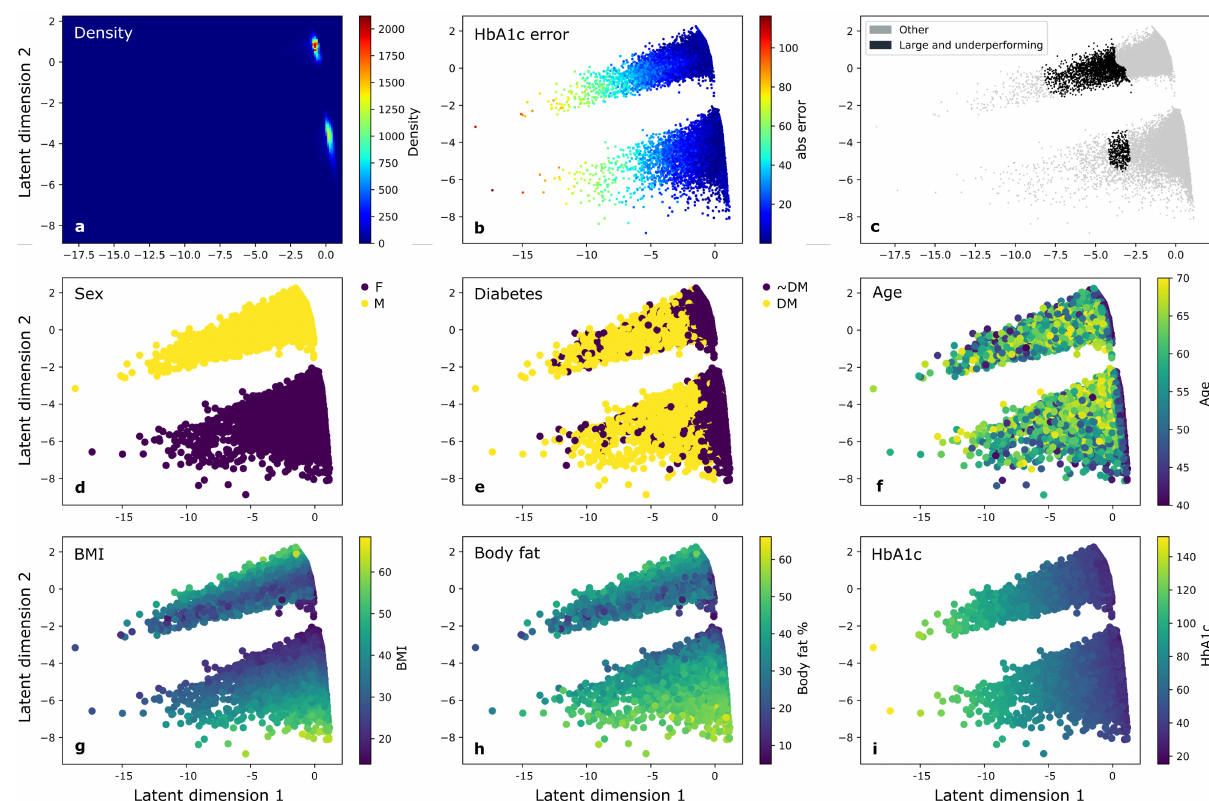
Fig. 4 Two-dimensional latent space. The space is coloured by data density ( a ), model error ( b, c ), and the values of selected variables ( d – i ). The space appears to be dominantly clustered by sex ( d) . The largest groups in the worst 25th performance percentile are shown in ( c ), associated with higher levels of HbA1c ( i ).